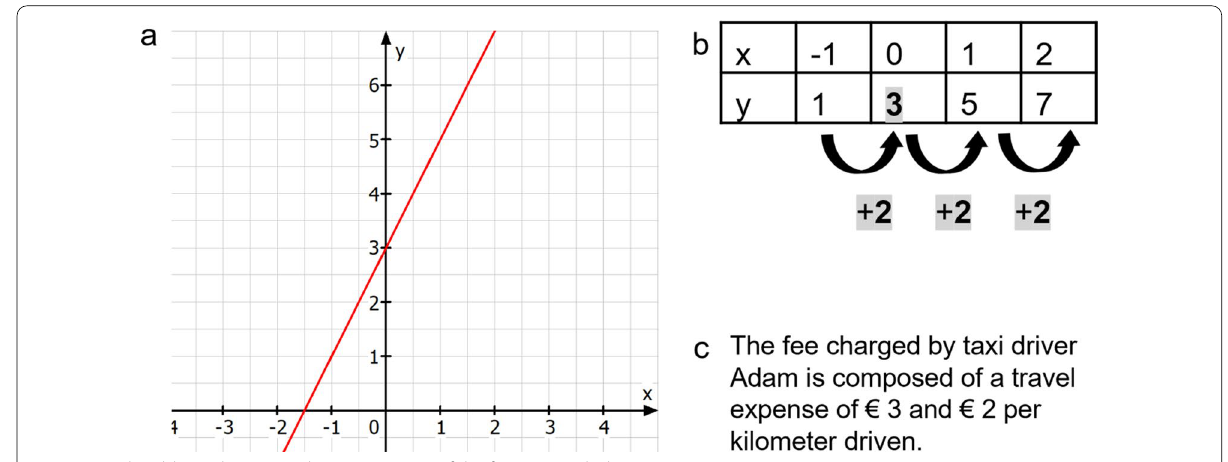
Fig. 1 Graph, table, and situational representation of the function with the equation y = 2 x +